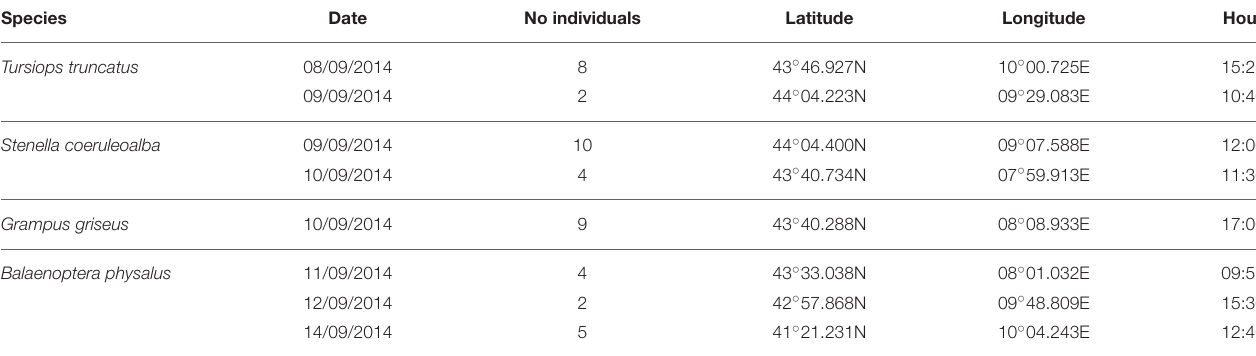
TABLE 1 | Cetaceans sightings in the Pelagos Sanctuary during the Plastic Pelagos survey. Species Date No individuals Latitude Tursiops